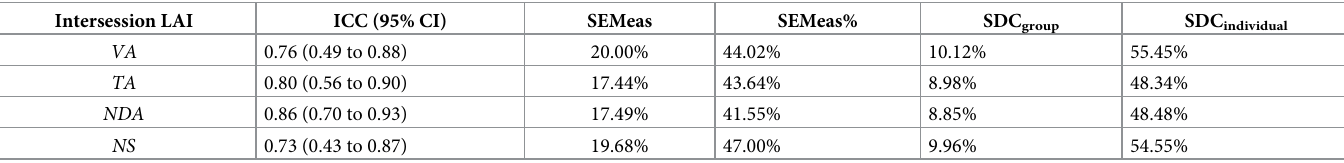
Table 5. Intersession reliability statistics LAI. SEM eas , SDC individual, SDC group are expressed as a percentage of the unconditioned MEP. In contrast, %SEM eas is expresses the SEM eas as a percentage of the